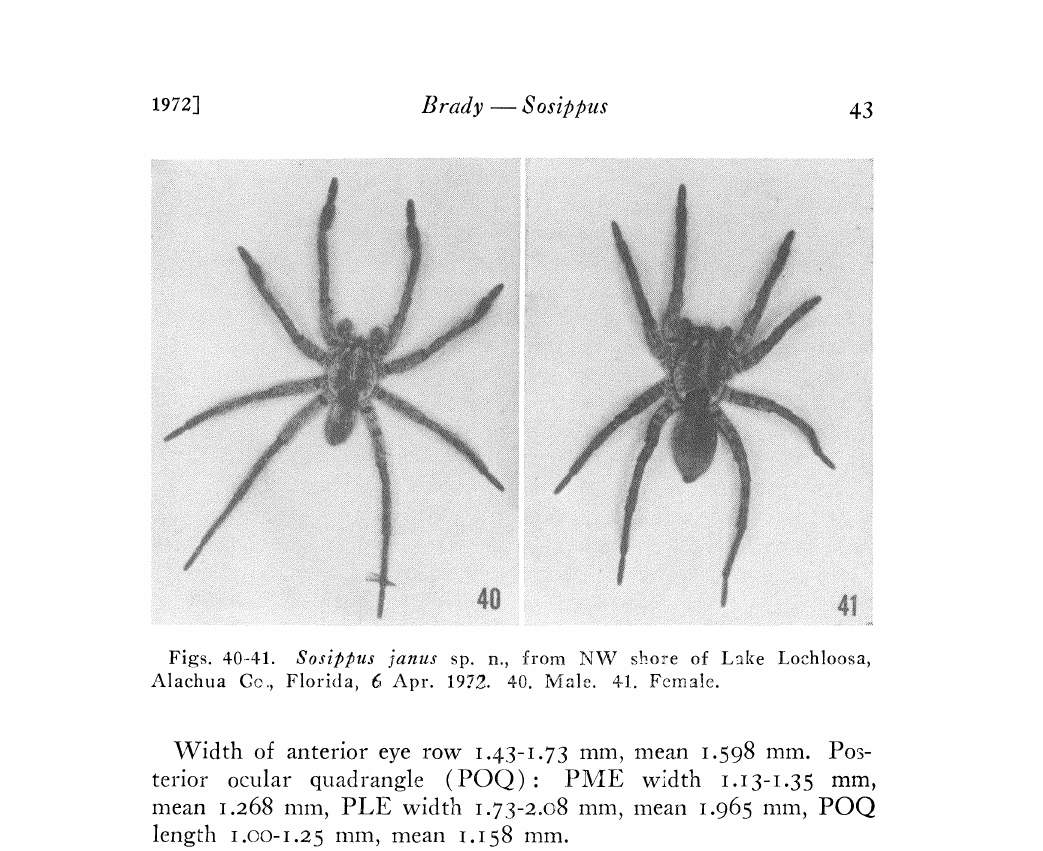
Figs. 40.-41. Sosippus janus sp. n., from. NW shore of Lake Lochloosa, Alachua Co., Florida, 6 Apr. 19.2. 40. Male. 4.1. Female. Width of anterior eye row 1.43-1.73 mm, mean 1.598 mm. Pos- terior ocular quadrangle (POQ): PME width I.I3-I.35 mm, mean 1.268 mm, PLE width 1.73-2.o8 mm, mean 1.965 mm, POQ length I.OO-I.25 ram, mean 1.158 mm. Leg IV: femur 5.5-6.9 ram, mean 6.31 mm, patella-tibia 6.4- 8.2 mm, mean 7.42 mm, metatarsus 5.7-7.5 mm, mean 6.64 mm, tarsus 2.8-3.5 mm, mean 3.1o mm, total length 2o.4-26.1 ram, mean 23.46 mm. Patella-tibiae: I 6.0-7.6 mm, mean 6.8o mm, II 5.5-7.o mm, mean 6.27 ram, III 4.7-6.2 mm, mean 5.5o mm. Color. Male. Pattern illustrated in Figure 4o. Face dark red- dish brown, with broad white stripes o.n each side extending from below P ME diagonally downward toward cheliceral condyles. Eye region black. Chelicerae dark reddish brown, black distally. Palpi brownish yellow to brown. Carapace reddish brown with three stripes of white hair in ce- phalic region: a median stripe beginning between PLE and extending to thoracic groove, a pair of white stripes beginning inside PLE continuing diagonally tangent to inner surface of PLE and